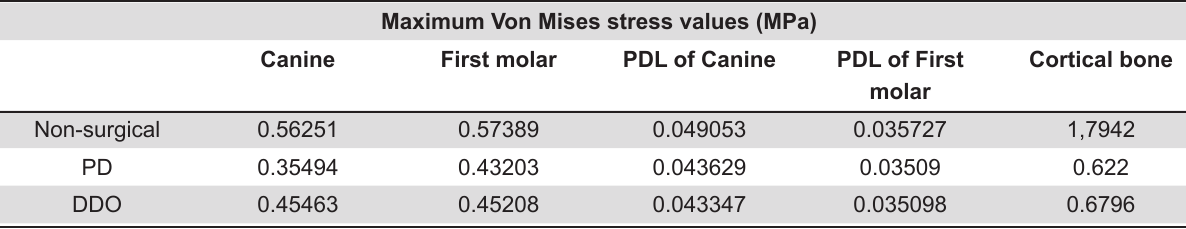
PD=periodontal distraction; PDL= periodontal ligament DDO=dentoalveolar distraction osteogenesis